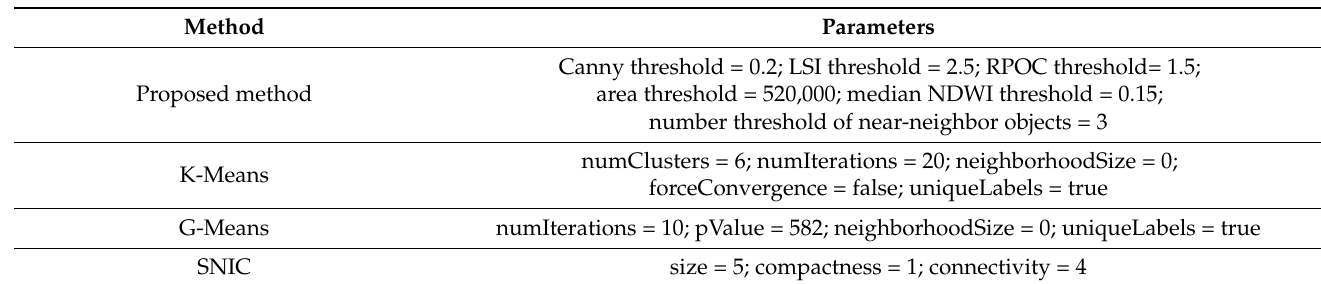
Table 4. Parameters setting for the proposed and comparative methods.